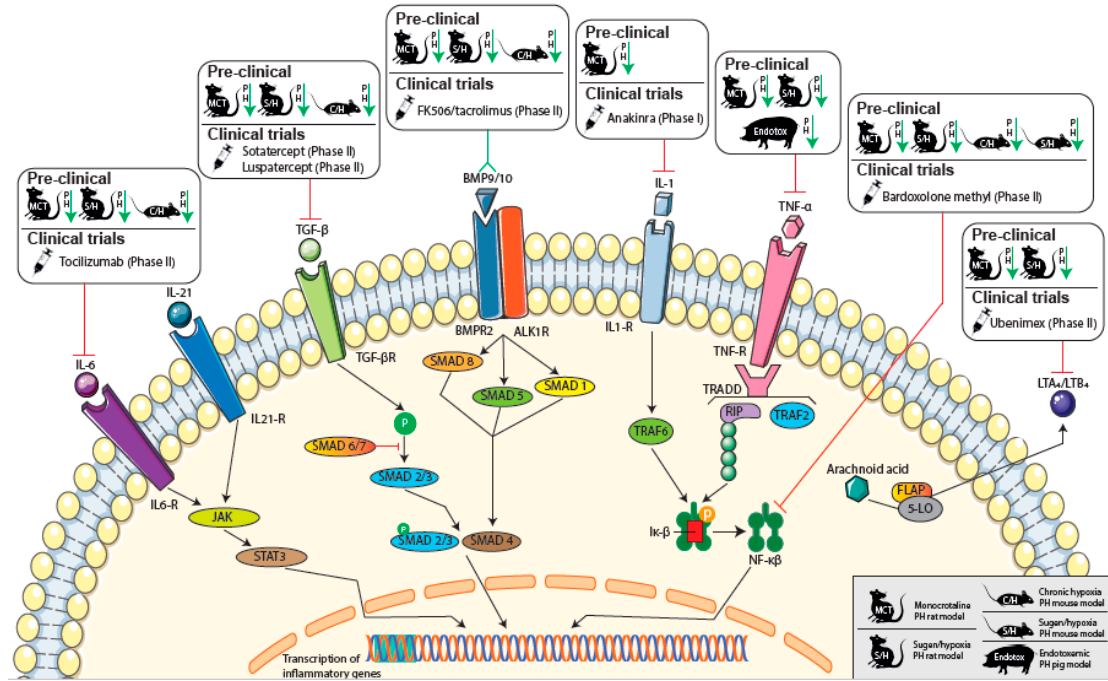
Figure 2. Immunomodulatory therapeutic targets in PAH. Schematic overview of (pre-)clinical targets for immunomodulatory therapy in pulmonary arterial hypertension (PAH) patients. Pre-clinical animal PH model signs are mentioned in the legend in the bottom right corner. Interleukin (IL); transforming growth factor beta (TGF- β ); bone morphogenetic protein (BMP); bone morphogenetic protein receptor type II (BMPR2); tumor necrosis factor-a (TNF- α ); nuclear factor kappa-light-chain-enhancer of activated B cells (NF- κβ ,); Leukotriene A4/B4 (LTA4/B4). Janus kinases (JAK); signal transducer and activator of transcription proteins (STAT); small mothers against decapentaplegic (SMAD); TNF receptor-associated factor (TRAF); tumor necrosis factor receptor type 1-associated death domain (TRADD); receptor-interacting protein (RIP) ; inhibitor of κβ (I κ - β ); 5-lipoxygenase activating protein (FLAP); arachidonate 5-lipoxygenase (5-LO).